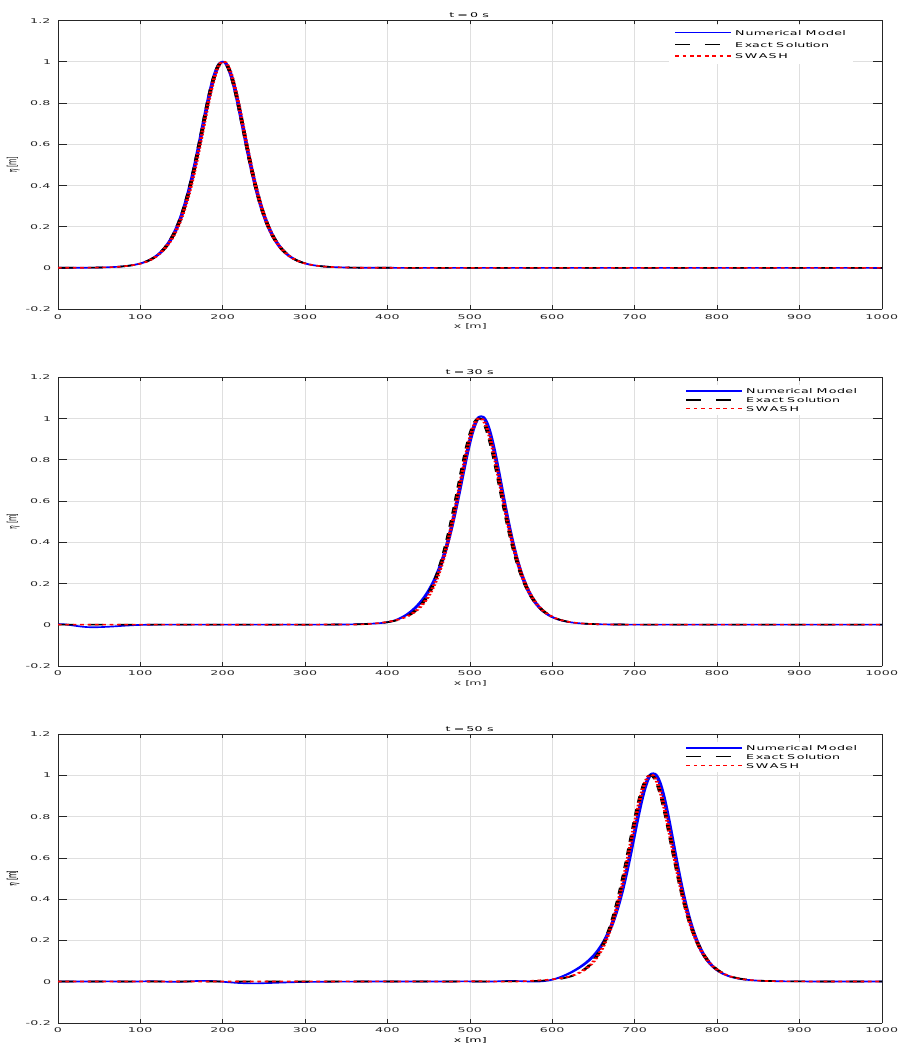
Figure 5. Comparison of numerical solitary waves (solid line) with the analytical result (dashed-line) and SWASH result (dots) at subsequent time t = 0,30,50 s